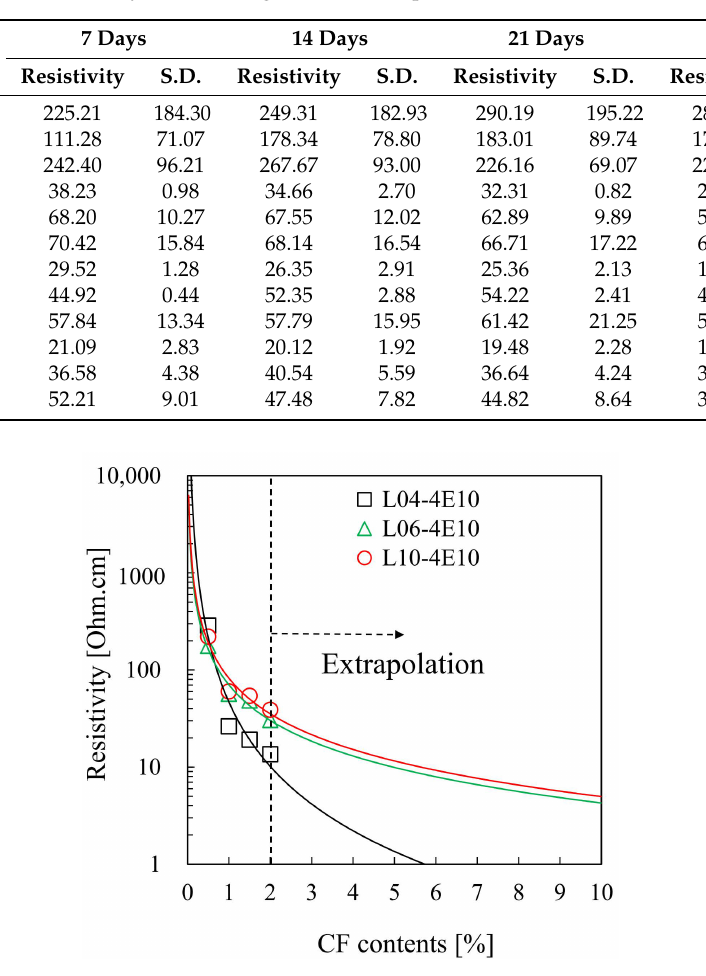
Figure 7. Resistivity of cement composites measured via four-probe configuration as a function of the carbon fiber (CF) content at the electrode spacing of 10 mm (4E10) for di ff erent CF lengths; L04, L06, and L10 correspond to the CF lengths of 4, 6, and 10 mm,